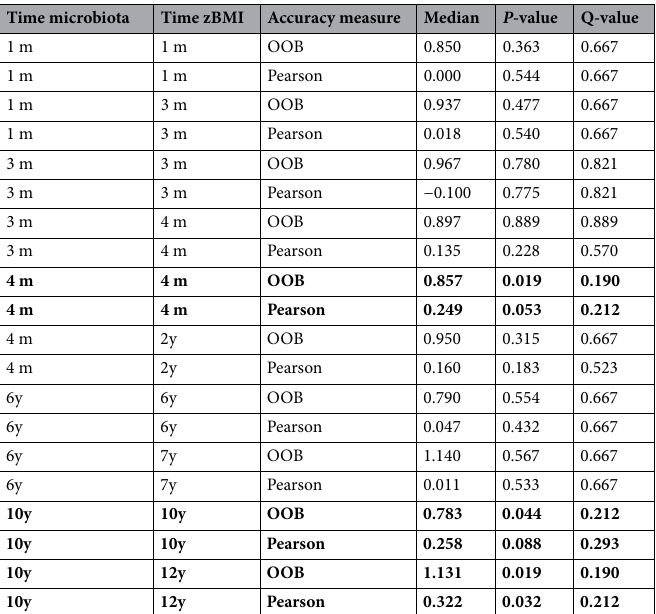
Table 4. Accuracy of the Random Forest models. OOB = Out of Bag error of the Random Forest models. Median = Median accuracy score (either OOB or Pearson) from the 10 times repeated fourfold crossvalidation procedure. Models that reached p < .05 for either Pearson or OOB are printed in